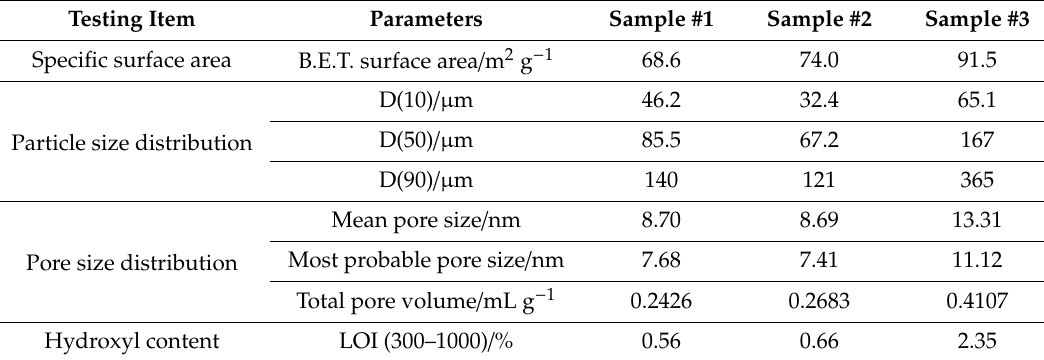
Table 2. Several adsorption-related properties of the tested alumina samples.